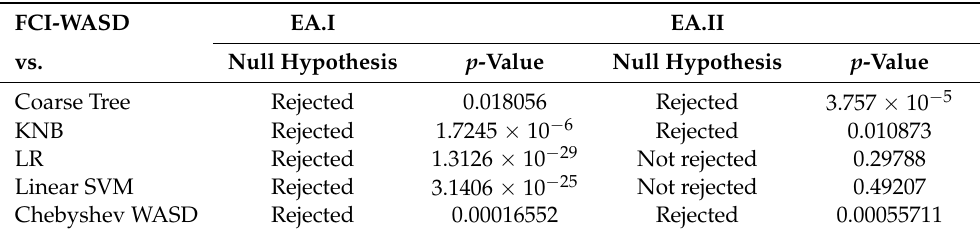
Table 2. McNemar test for the